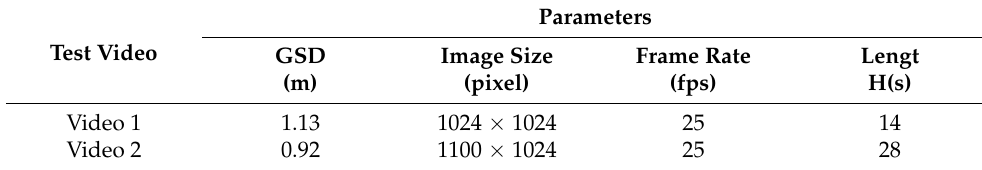
Table 2. Parameters of remote sensing